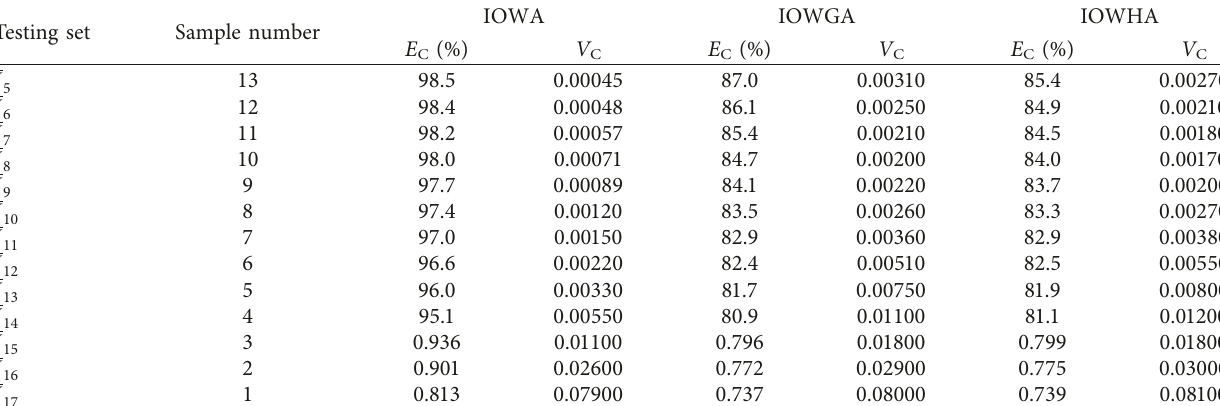
Table 8: Statistics of evaluation index parameters calculated by different models in testing